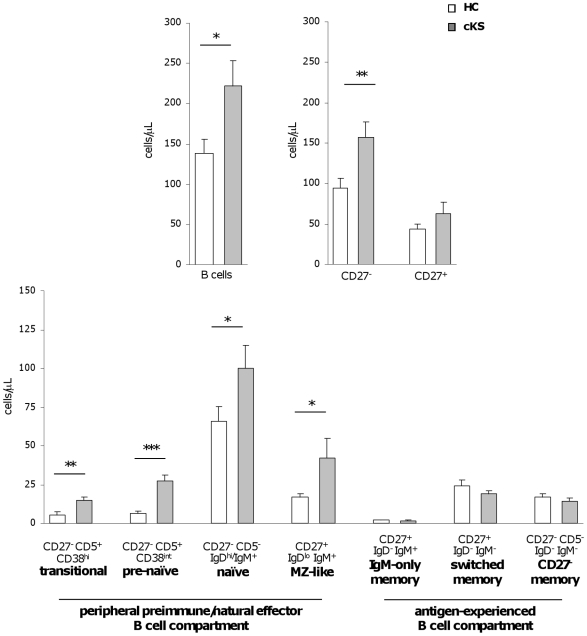
B cells and their non-memory subsets are increased in patients with cKS.The number of total B cells and CD27− B cells was significantly higher in cKS patients (grey bars) than HCs (white bars). All the subsets composing the preimmune/natural effector compartment, namely transitional, pre-naïve, naïve and MZ-like B lymphocytes, were increased in cKS patients, while the subsets composing the antigen-experienced T cell-dependent compartment, namely IgM-only, switched and CD27− memory B cells, were unaffected. Data shown as mean ± SE. P-values calculated using the Student t test for independent samples. *P<.05; **P<.01; ***P<.001.